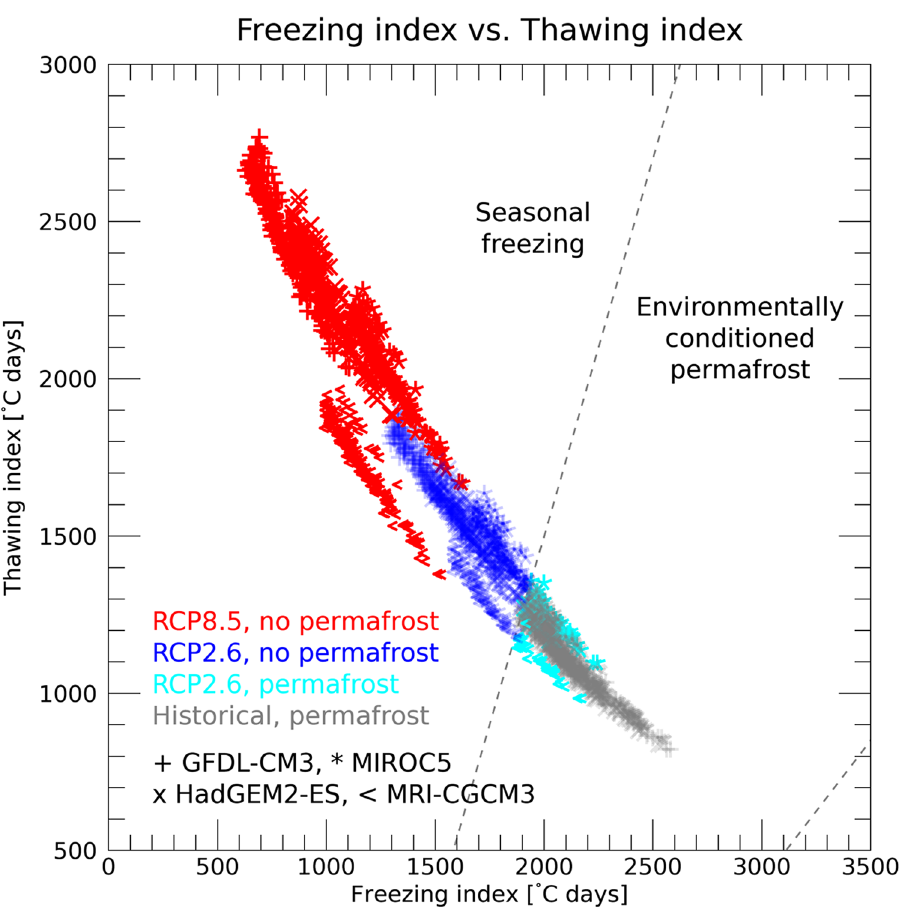
Figure 5. Scatter plot of freezing and thawing indices in the Daisetsu Mountains. The method used to produce the plot is the same as that in Fig. 4. Bias-corrected climate scenarios based on the four global climate models are used to calculate the freezing and thawing index averaged over the last 30 years. Areas of “Environmentally conditioned permafrost” and “Seasonally freezing” follow the definitions given in "Statistical method for inferring permafrost distribution"